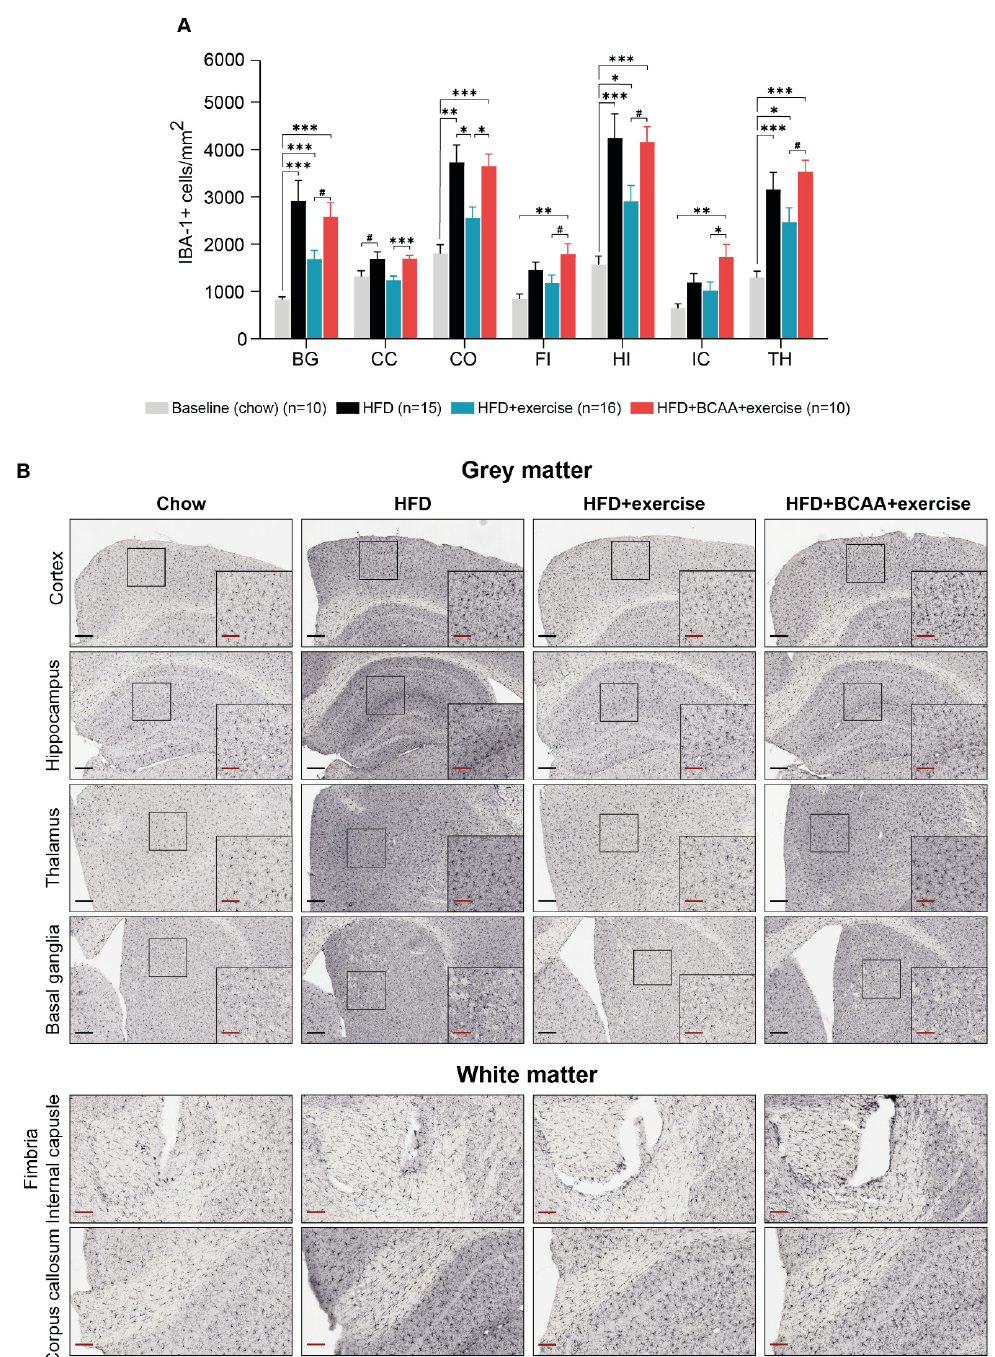
Figure 11. Neuroinflammation. Immunohistochemical analysis of ionized calcium-binding adapter molecule (IBA-1), as a measure of neuroinflammation in different brain regions of interest (basal ganglia (BG), corpus callosum (CC), cortex (C), fimbria (FI), hippocampus (HI), internal capsule (IC), and thalamus (TH)). ( A ) The number of IBA-1+ cells/mm 2 was analyzed in young chow-fed animals (baseline), HFD, HFD + exercise, and HFD + BCAA + exercise groups. ( B ) Representative